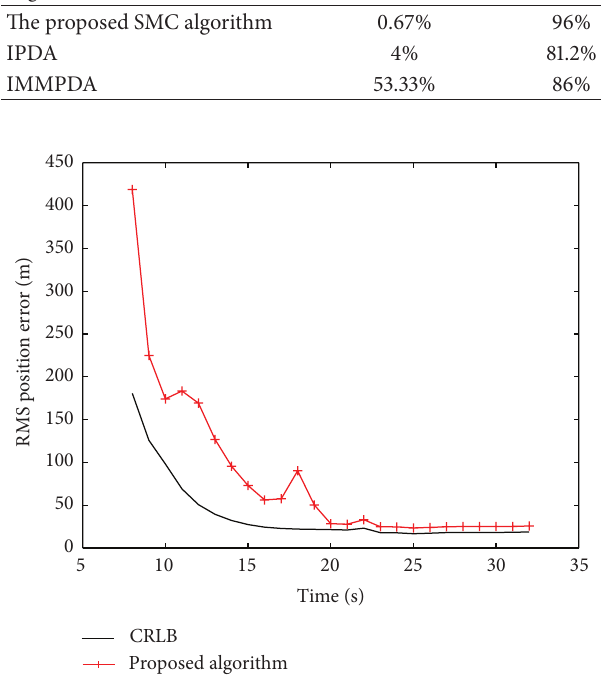
Figure 4: RMS position error in comparison with the posterior